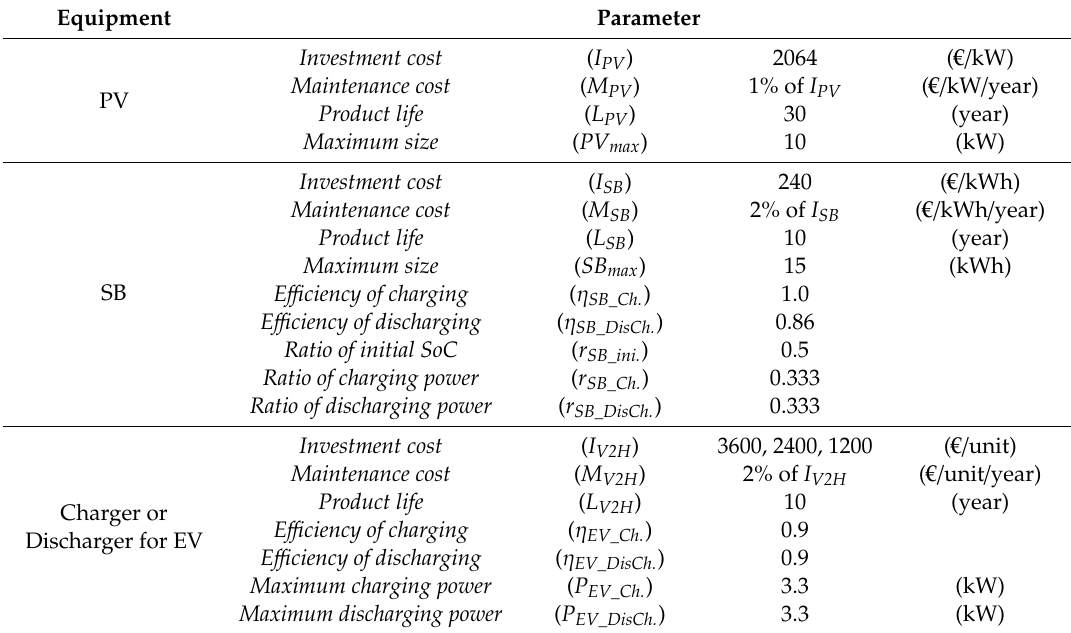
Figure 6. Normalized power production of photovoltaic (PV). Table 3. System parameters of